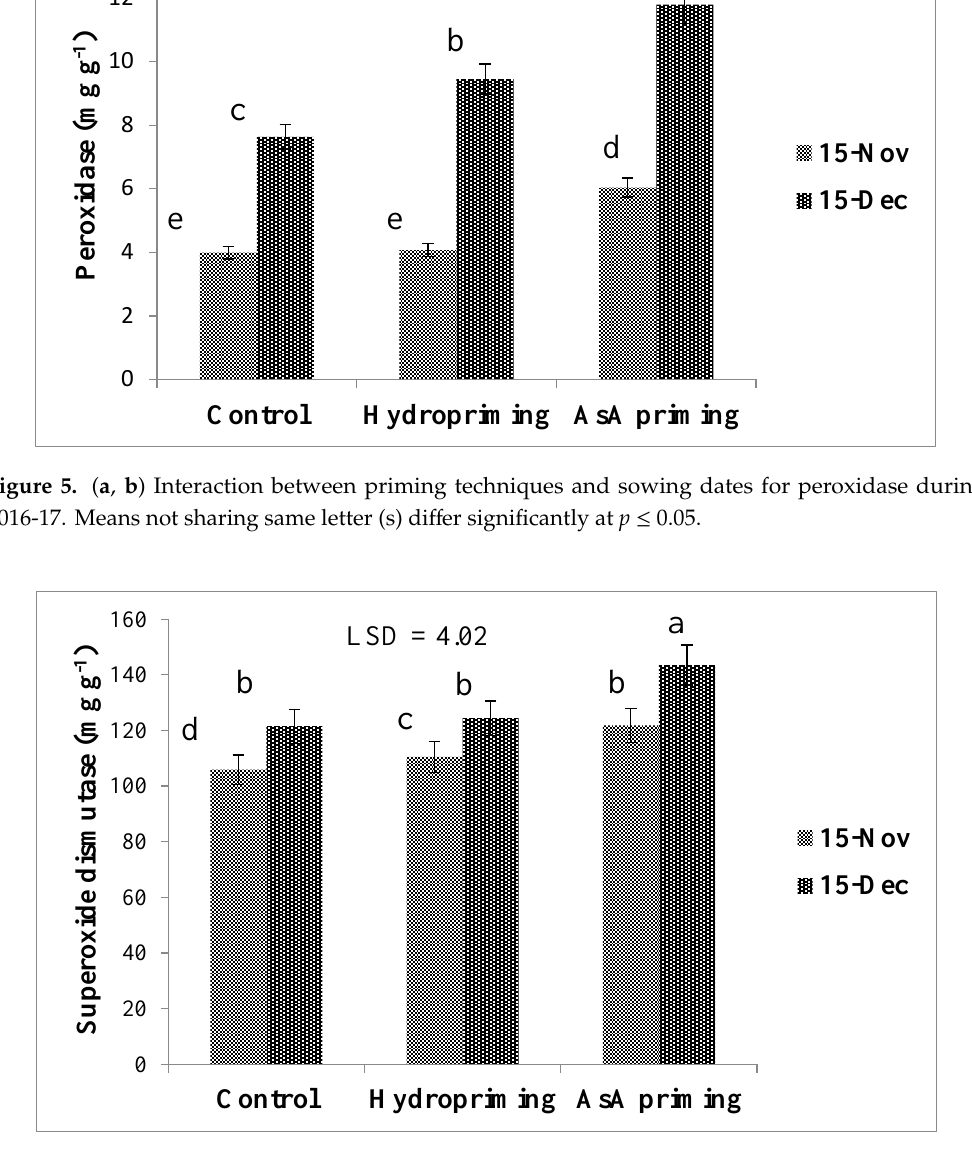
Figure 6. Interaction between priming techniques and sowing dates for superoxide dismutase during 2017. Means not sharing same letter (s) differ significantly at p ≤ 0.05.